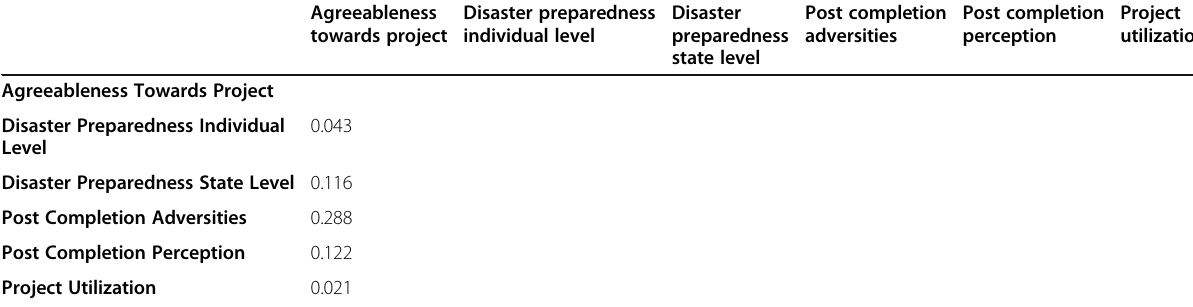
Table 11 Effect size ( f 2 )